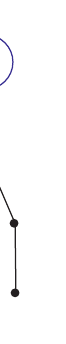
Figure 9: The trees T and T